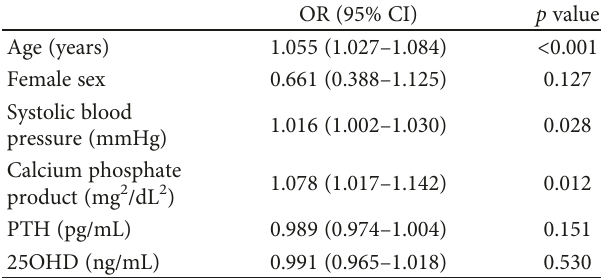
Table 2: Multivariable analysis for the presence of carotid